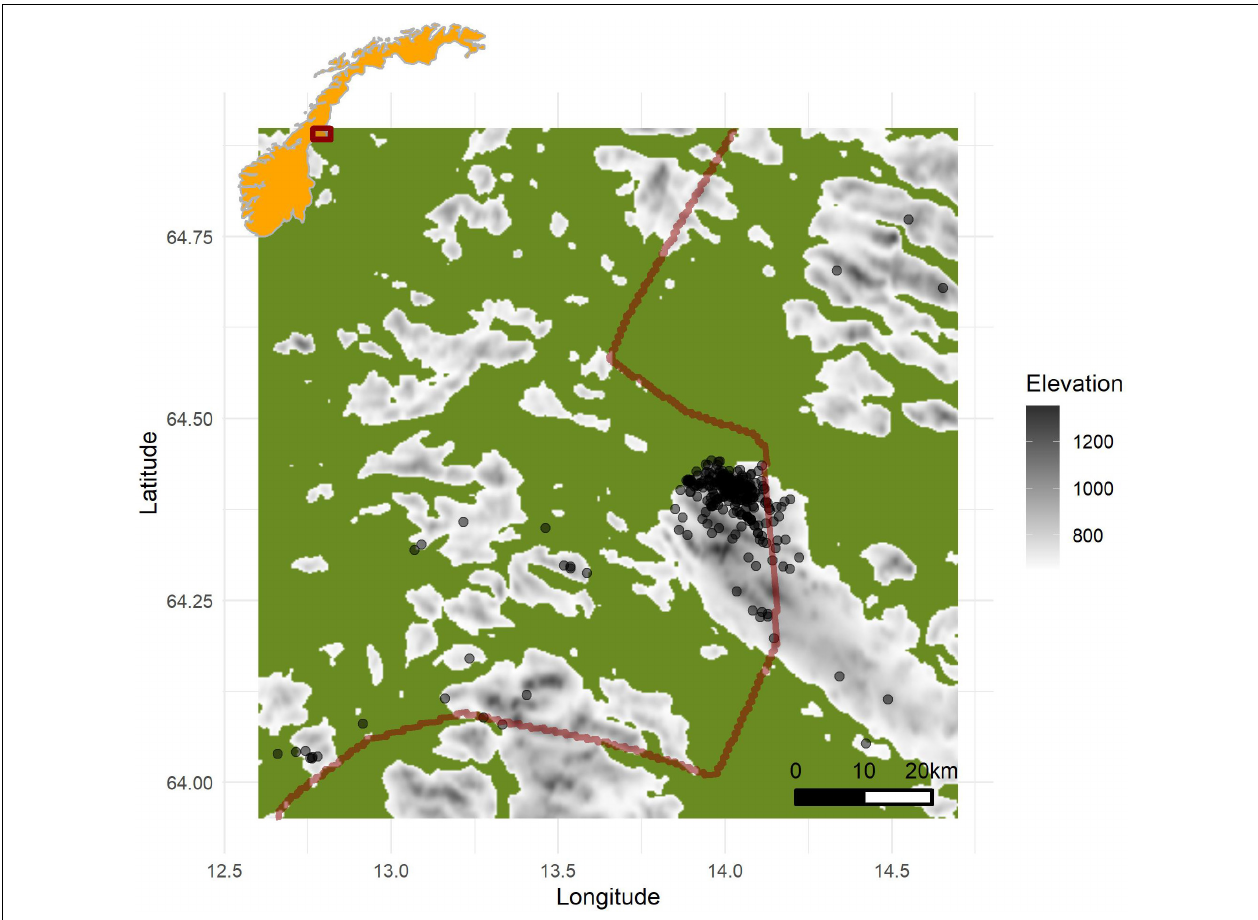
FIGURE 1 | Map of the study area. Inset map: Norway marked in orange, and study area marked with a red rectangle. In the main map, areas below 650 masl is marked in green, and areas above 650 (corresponding roughly to habitats used by rock ptarmigan) is gray shaded by elevation. The border between Norway (west) and Sweden (east) is marked with a red line. Captures and relocations of rock ptarmigan is marked with black dots.